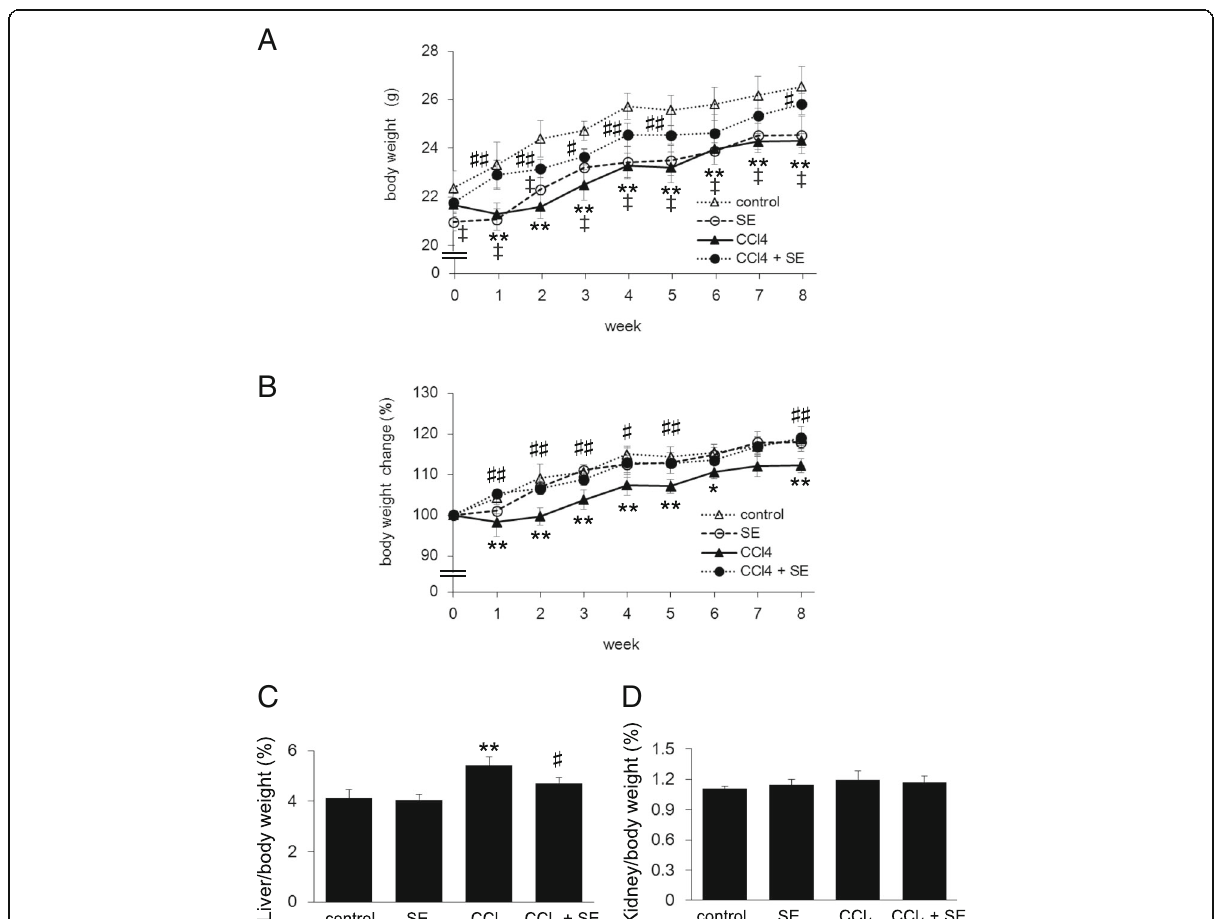
Fig. 2 Effect of SE on body weight change resulting from CCl 4 -induced hepatotoxicity. Mice were given CCl 4 dissolved in olive oil intraperitoneally twice per week for 8 weeks. The control and SE groups received olive oil. At all periods of the experiment, mice were treated daily with SE or saline. Body weights were measured weekly throughout the study. Body weight and body weight change were calculated from the beginning of the study. Animals were euthanized 72 h after the final CCl 4 injection. Panels a , b , c , and d indicate body weight, body weight change ratio, liver weight ratio, and kidney weight ratio, respectively. The data represent the mean±SD of 6 mice per group; ‡ p <0.01 (control versus SE group), ** p <0.01 (control versus CCl 4 group), and # p <0.05 and ## p <0.01 (CCl 4 versus CCl 4 +SE